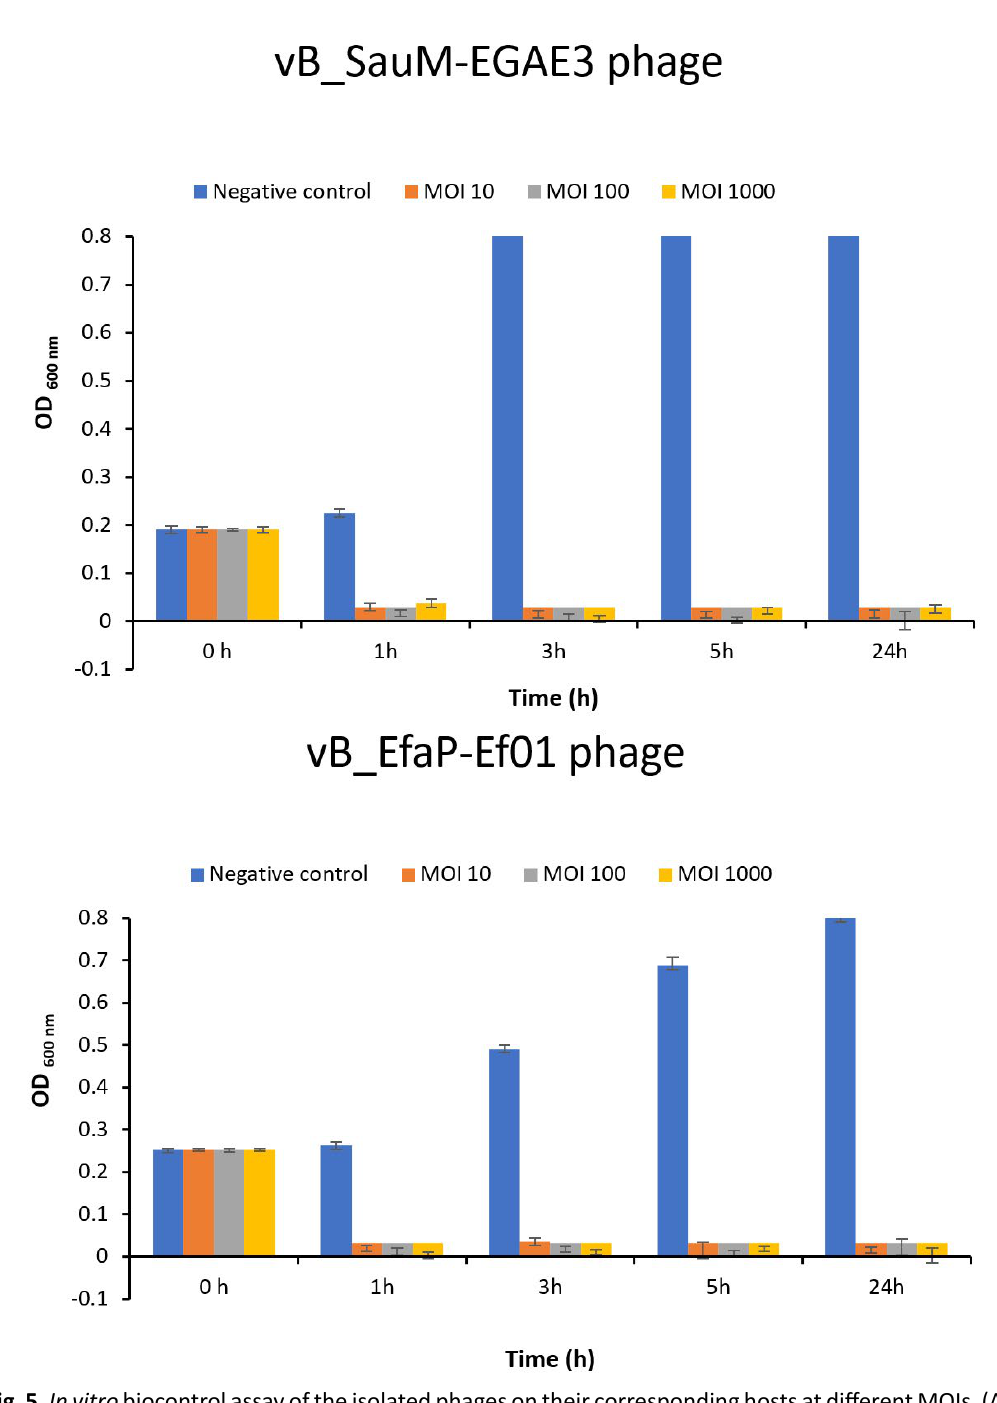
Fig. 5. In vitro biocontrol assay of the isolated phages on their corresponding hosts at different MOIs. (A) Lytic activity of vB_SauM-EGAE3 phage on S. aureus EG-AE3, and (B) Lytic activity vB_EfaP-Ef01 phage on E. faecalis EF01. Each bacteria was challenged with the corresponding phage at different MOIs of 10, 102, and 103. Bacterial growth was determined by measuring the optical density at 600